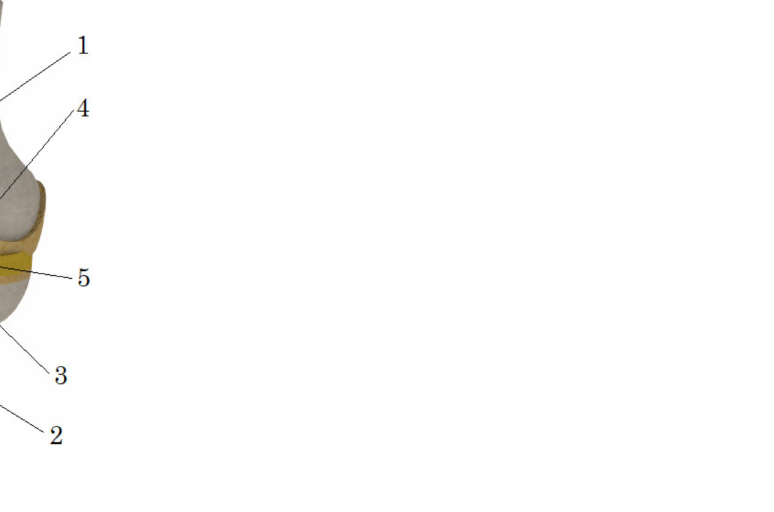
Figure 1. The numerical model of the knee joint: 1—femur; 2—tibia; 3, 4—cartilage;